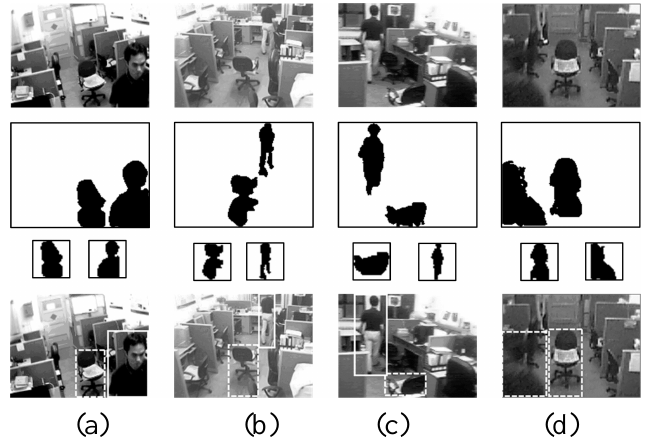
Figure 6. Signal processing results sequences in 4 of 18 wireless sensor nodes, where the solid rectangle represents that the classification result is human type and the dashed rectangle represents that the classification result is non-human